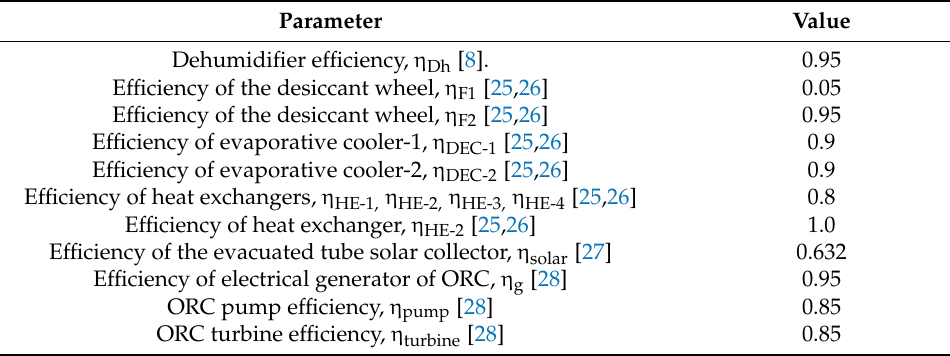
Table 2. Efficiencies of the systems